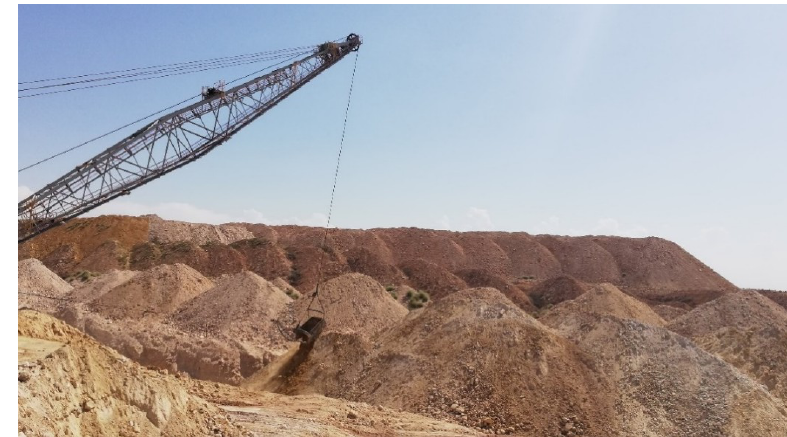
Figure 2. Phosphate mine waste rocks dumps.